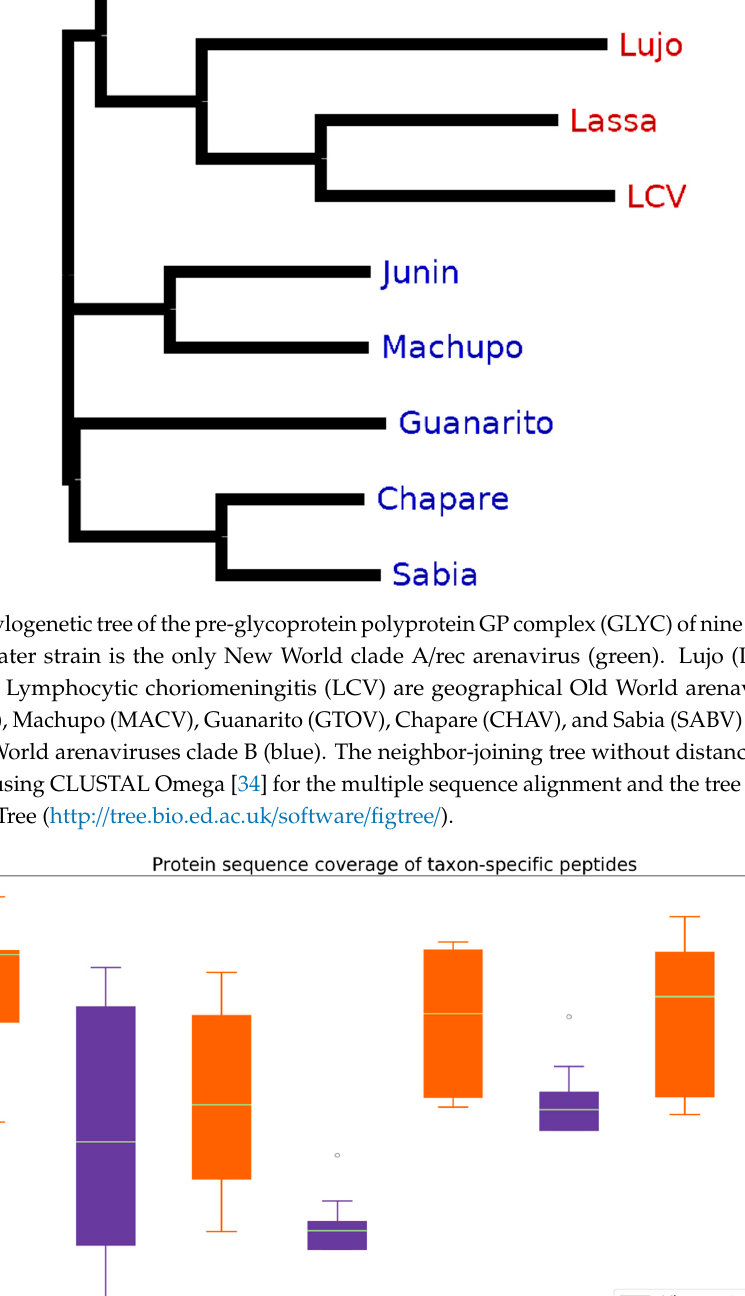
Figure 4. Relative amount of taxon-specific target peptides from nine arenavirus species proteomes. The ratio of unique to in silico-digested peptides is shown for exact (lighter colors) and homologous (darker colors) matching mode with a background consensus threshold of 80%. Orange bars show the results for the database consisting of four virus proteins for each arenavirus species. Purple bars individual proteins instead of whole proteomes. For example, proteins with low sequence coverage indicate results that were generated when adding protein sequences from all reviewed virus proteomes (from UniProt/Swiss-Prot) as additional background. based on taxon-specific peptides may be excluded.